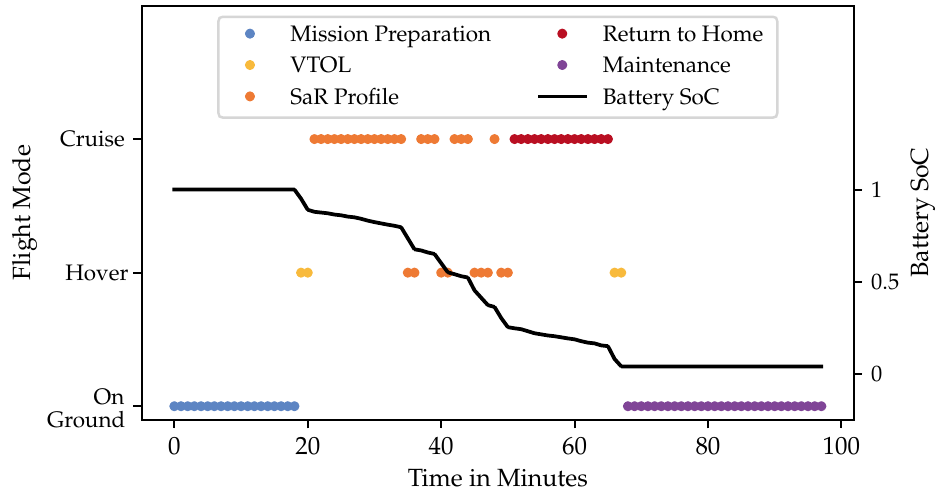
Figure 4. Search and rescue mission profile with different mission phases and energy